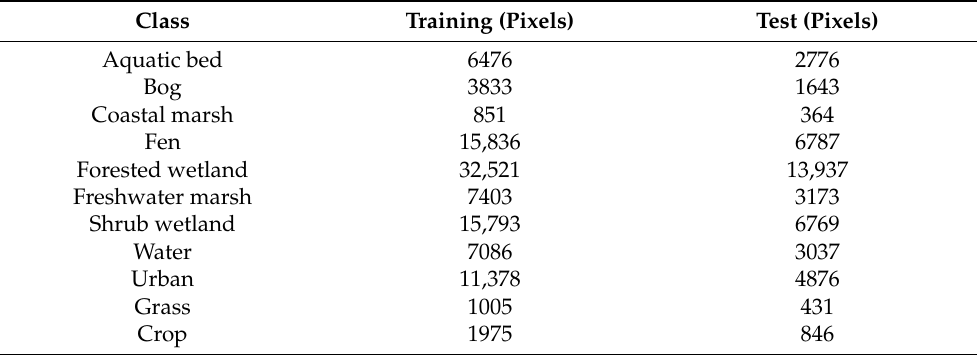
Figure 2. The flowchart of methods used in this study. Table 1. The number of training and test pixels for the wetland and non-wetlands in the pilot site of Saint John, New Brunswick, Canada.